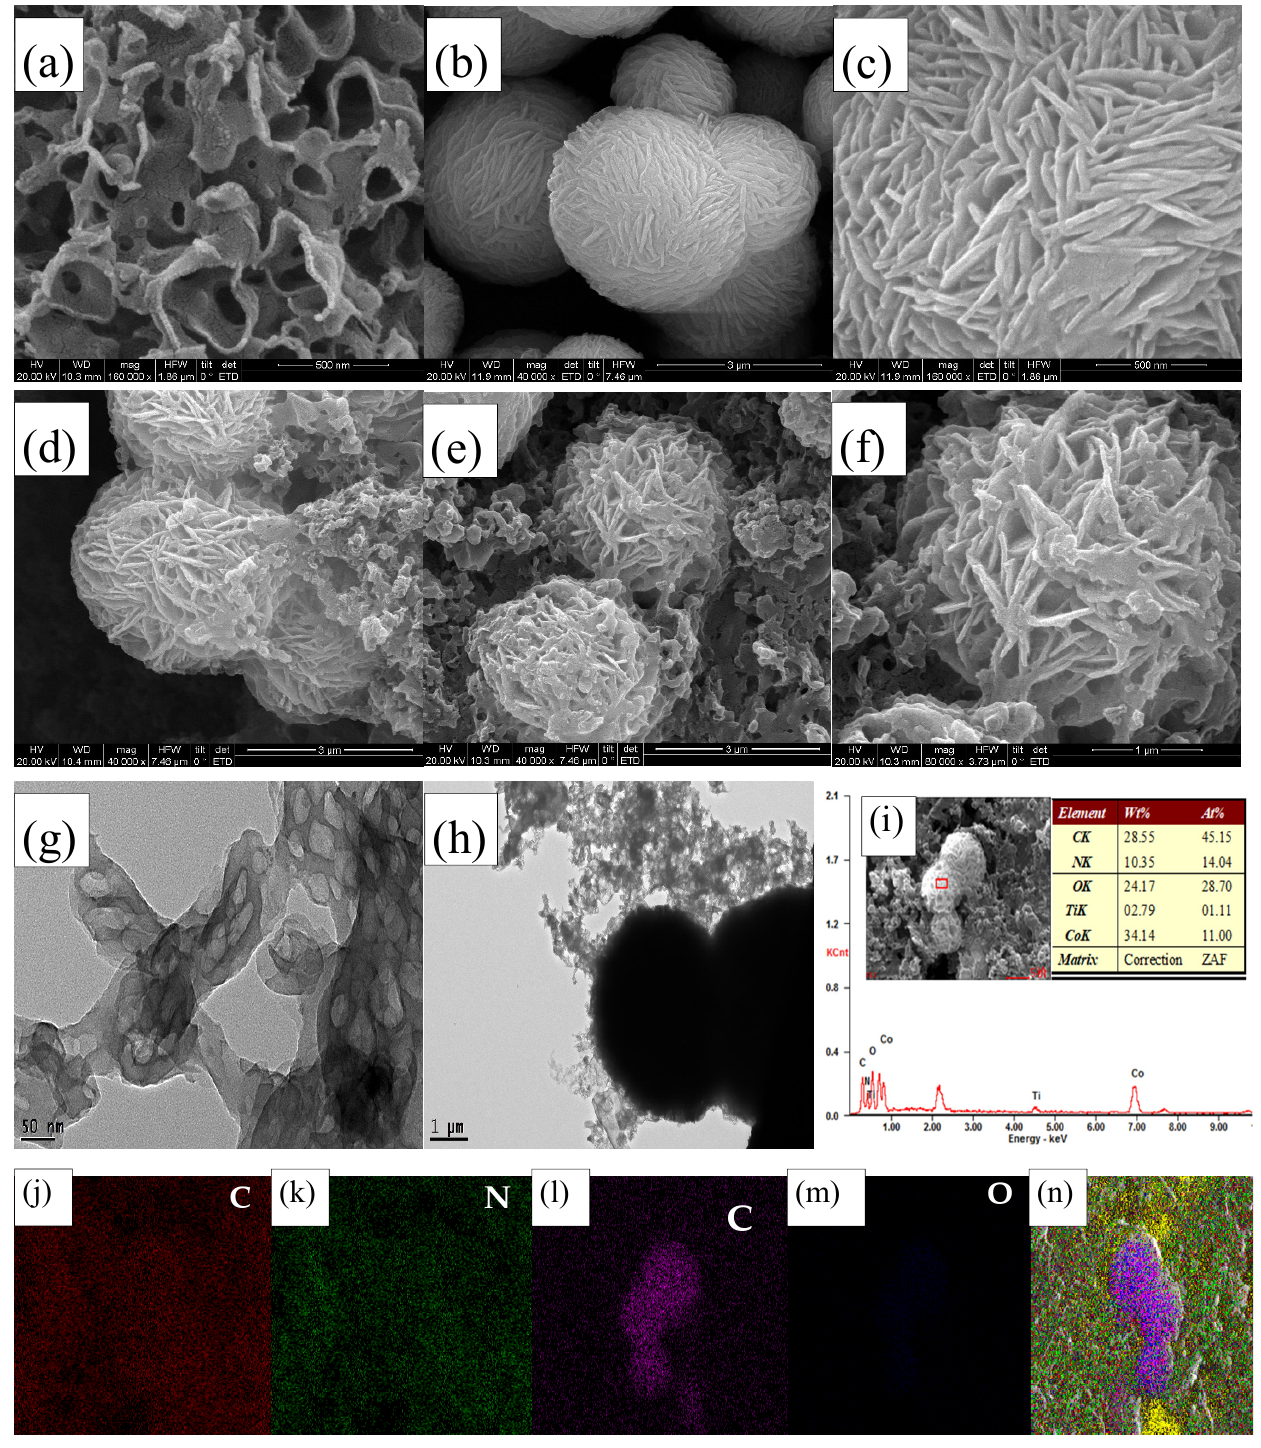
Figure 3. ( a ) SEM images of g-C 3 N 4 , ( b , c ) Fw-Co(OH) 2 , ( d – f ) Fw-Co(OH) 2 /g-C 3 N 4 ; ( g ) TEM images of g-C 3 N 4 , ( h ) Fw-Co(OH) 2 /g-C 3 N 4 ; ( i ) EDX of Fw-Co(OH) 2 /g-C 3 N 4 ; ( j – n ) elemental mapping images of a Fw-Co(OH) 2 /g-C 3 N 4 sample.